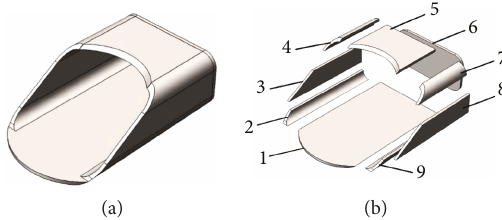
Figure 13: Disassembling schematic of the digging spoon used in the Apollo